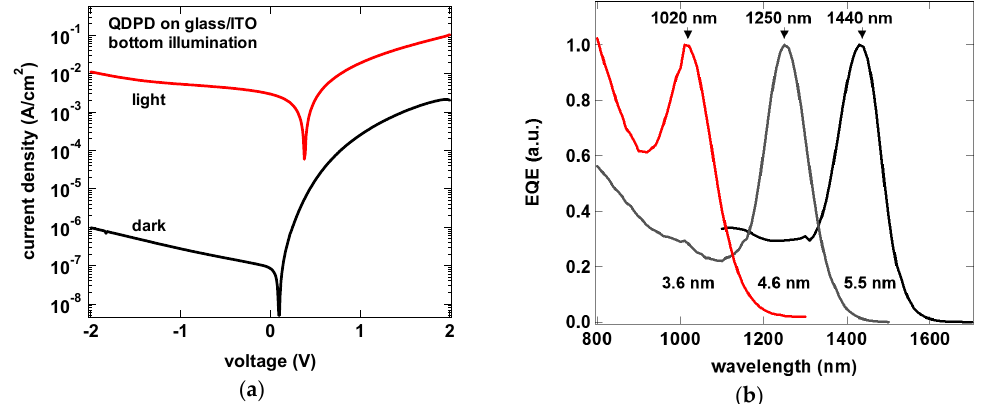
Figure 6. Current density vs. voltage of a bottom illuminated QDPD ( a ) and external quantum efficiency curves for different QD sizes used in the photoactive layer ( b ).